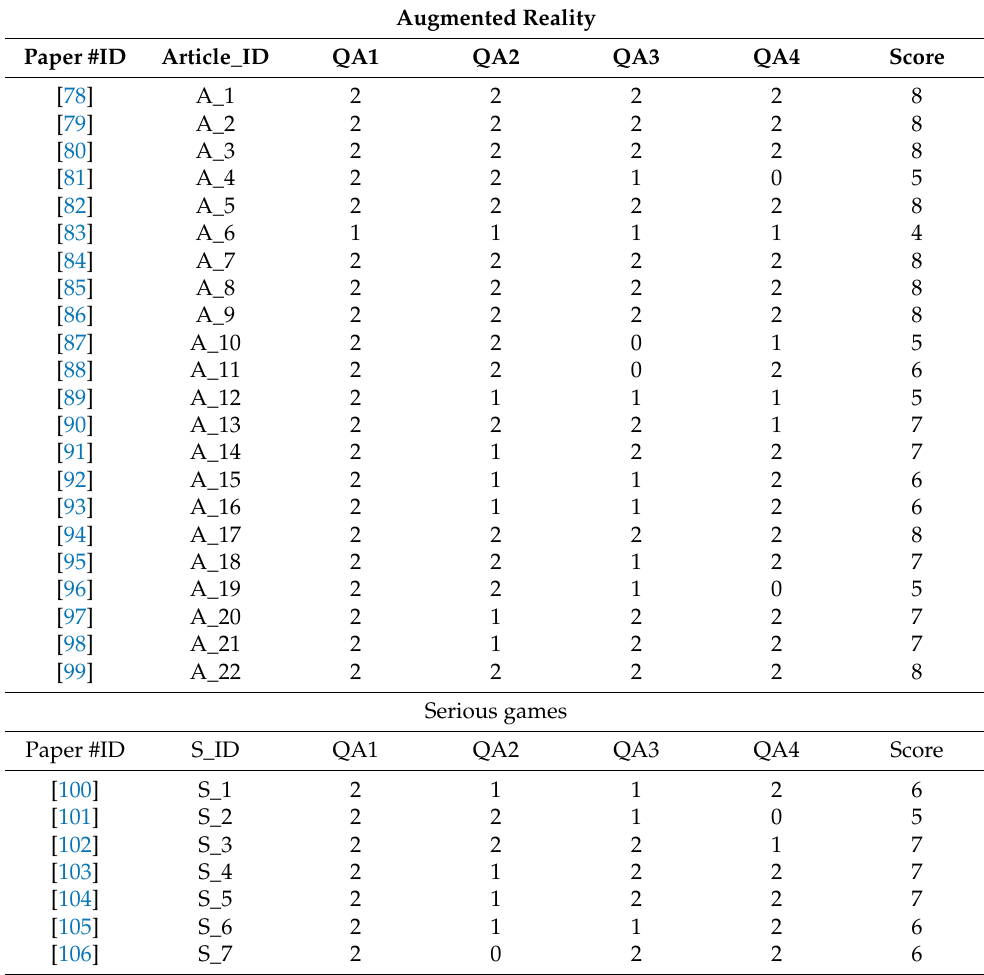
Table 7. Qualitative assessment of the related